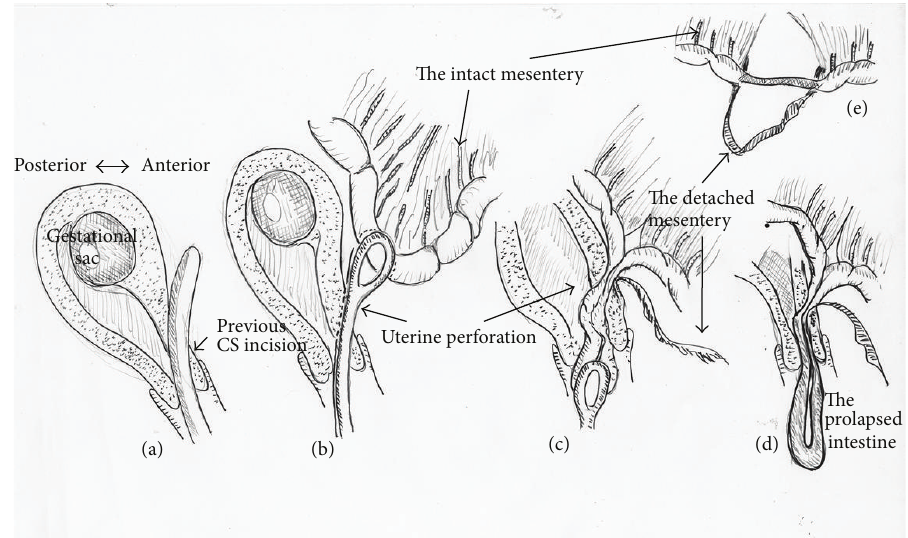
Figure 2: Schematic of the event. (a) The anterior uterine body wall was perforated with the Hegar dilator. The previous cesarean section incision was normal. (b) The forceps were extracted from the uterus through the perforation, grasping the ileum. (c) The ileum was pulled through the perforation site. The mesentery was detached when the ileum was pulled through the narrow perforation site. (d) The ileum prolapsed into the vagina. The ileum was strangulated at the perforation site. (e) The mesentery was completely separated from the bowel, resulting in ileal necrosis. Strangulation at the site of narrow perforation hole (d) may also have caused ileal